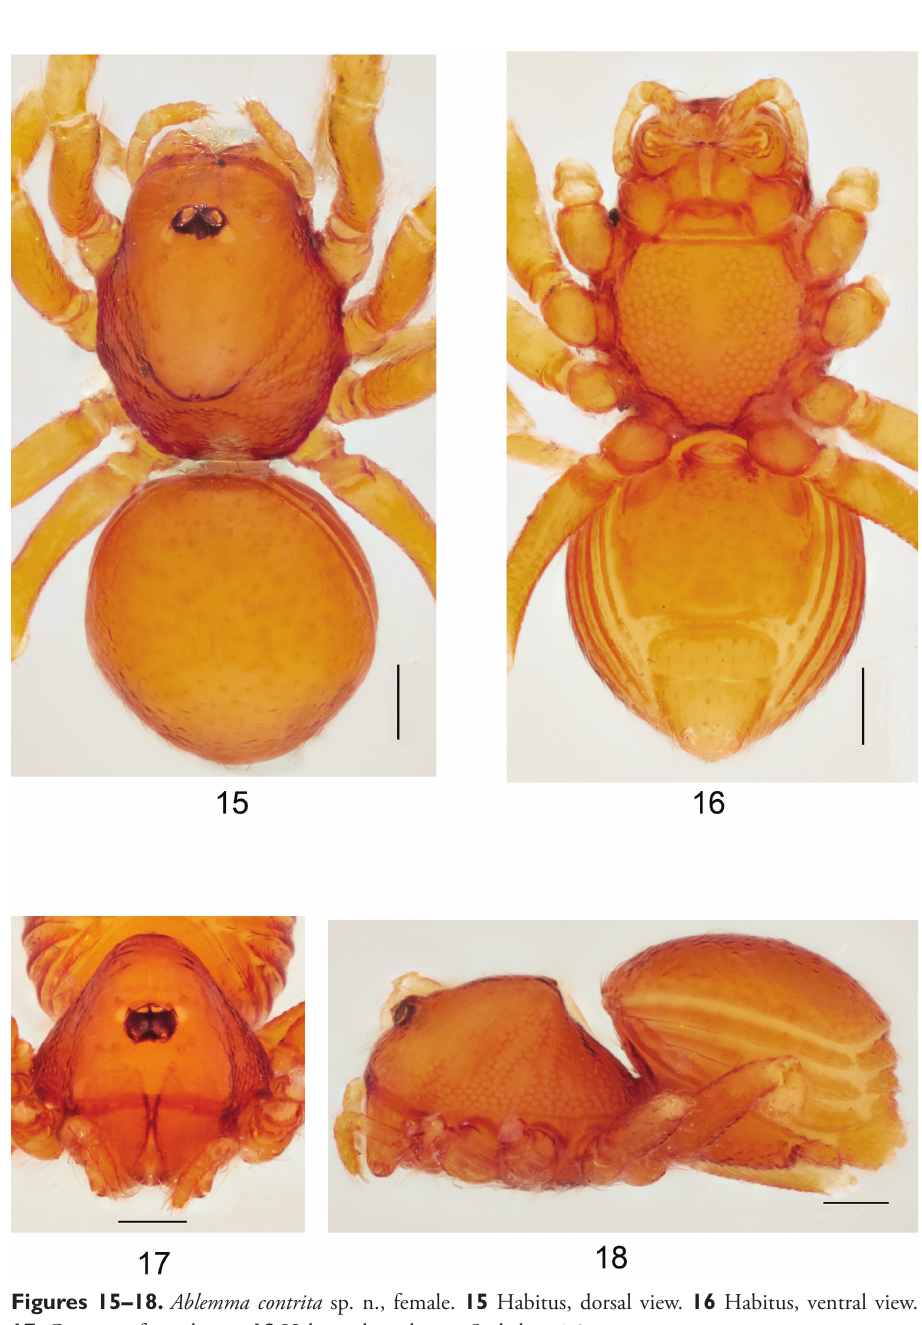
Figures 15–18. Ablemma contrita sp. n., female. 15 Habitus, dorsal view. 16 Habitus, ventral view. 17 Carapace, frontal view. 18 Habitus, lateral view. Scale bar: 1.0